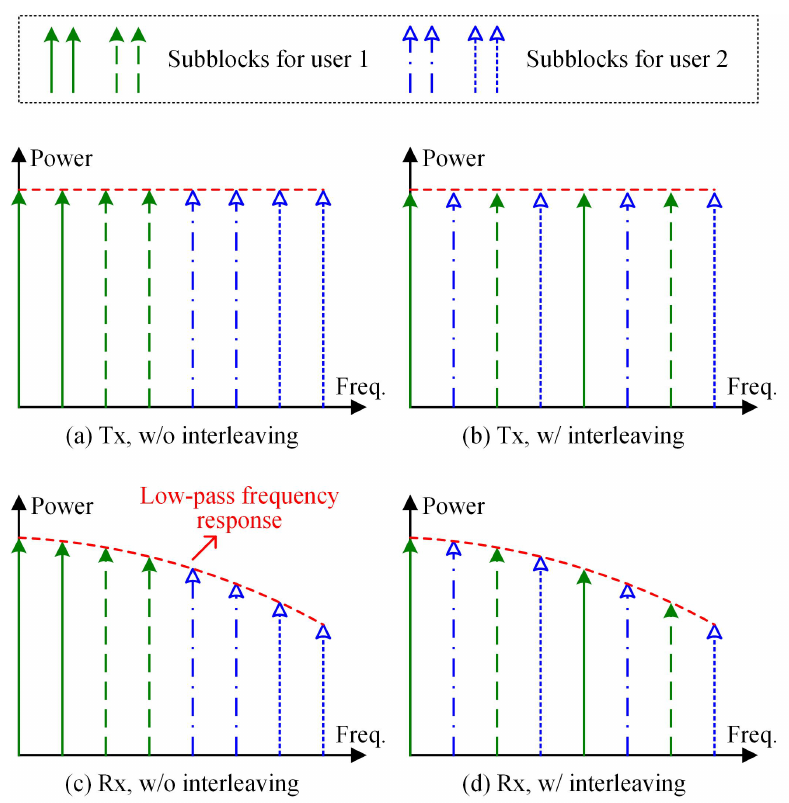
Figure 2. Illustration of transmitted spectrum ( a ) without interleaving and ( b ) with interleaving, and received spectrum ( c ) without interleaving and ( d ) with